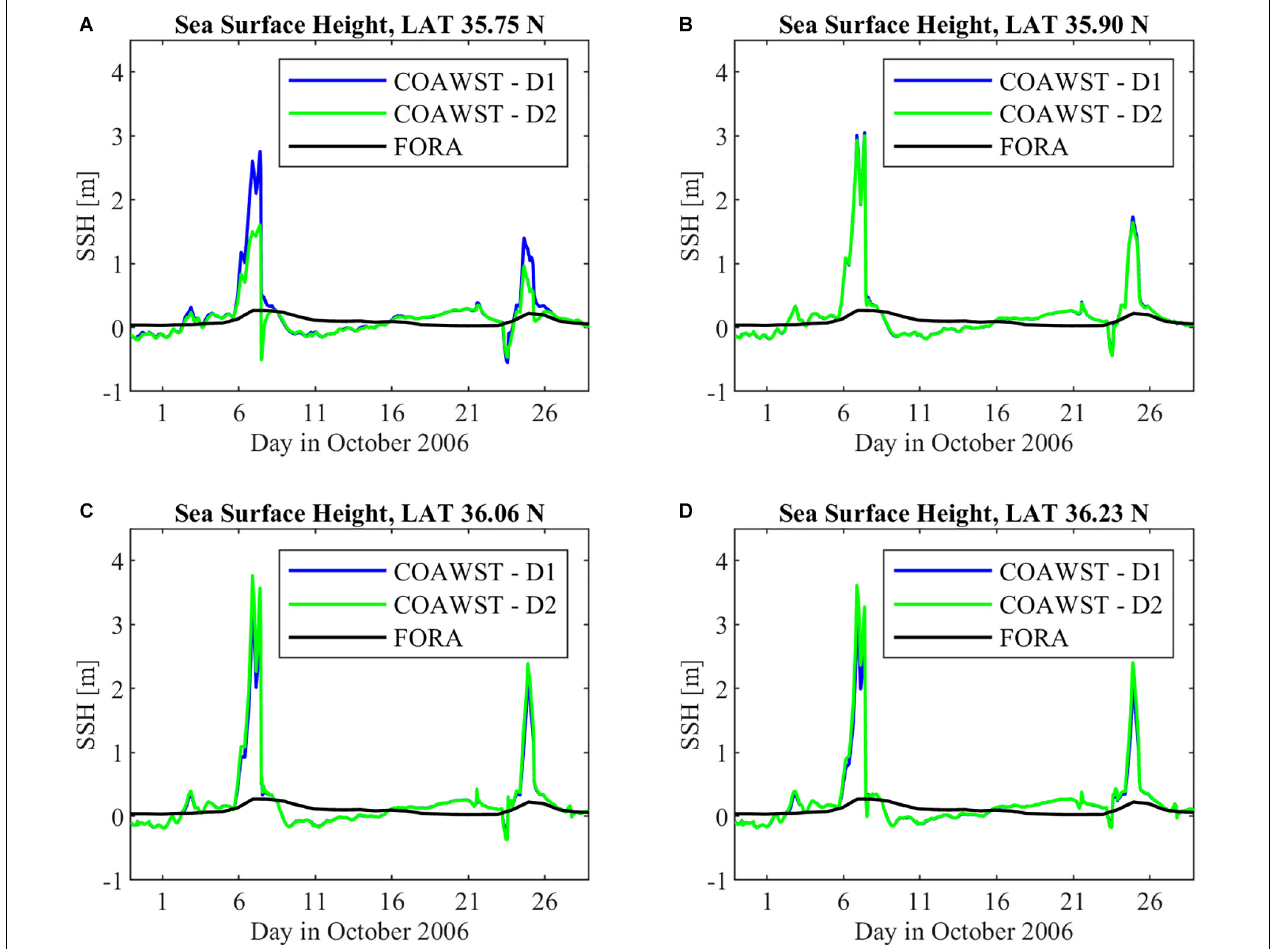
FIGURE 4 | Comparison of time series of modeled Sea Surface Height (blue – COAWST domain 1, green – COAWST domain 2, black – FORA) alongside the Ibaraki Coast on four locations corresponding to LON (A) 35.75 N, (B) 35.90 N, (C) 36.06 N, (D) 36.23 N.